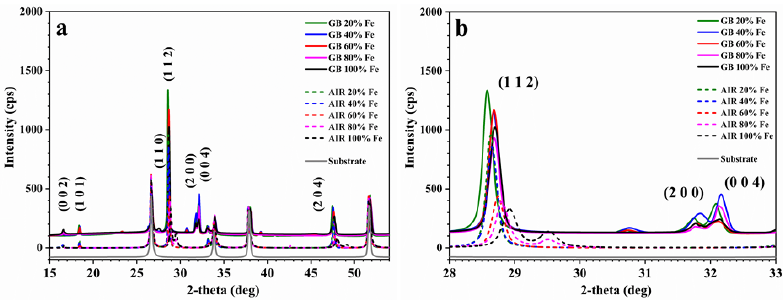
Figure 1. X-ray di ff raction (XRD) patterns of the 20%, 40%, 60%, 80%, and 100% CZFTS thin